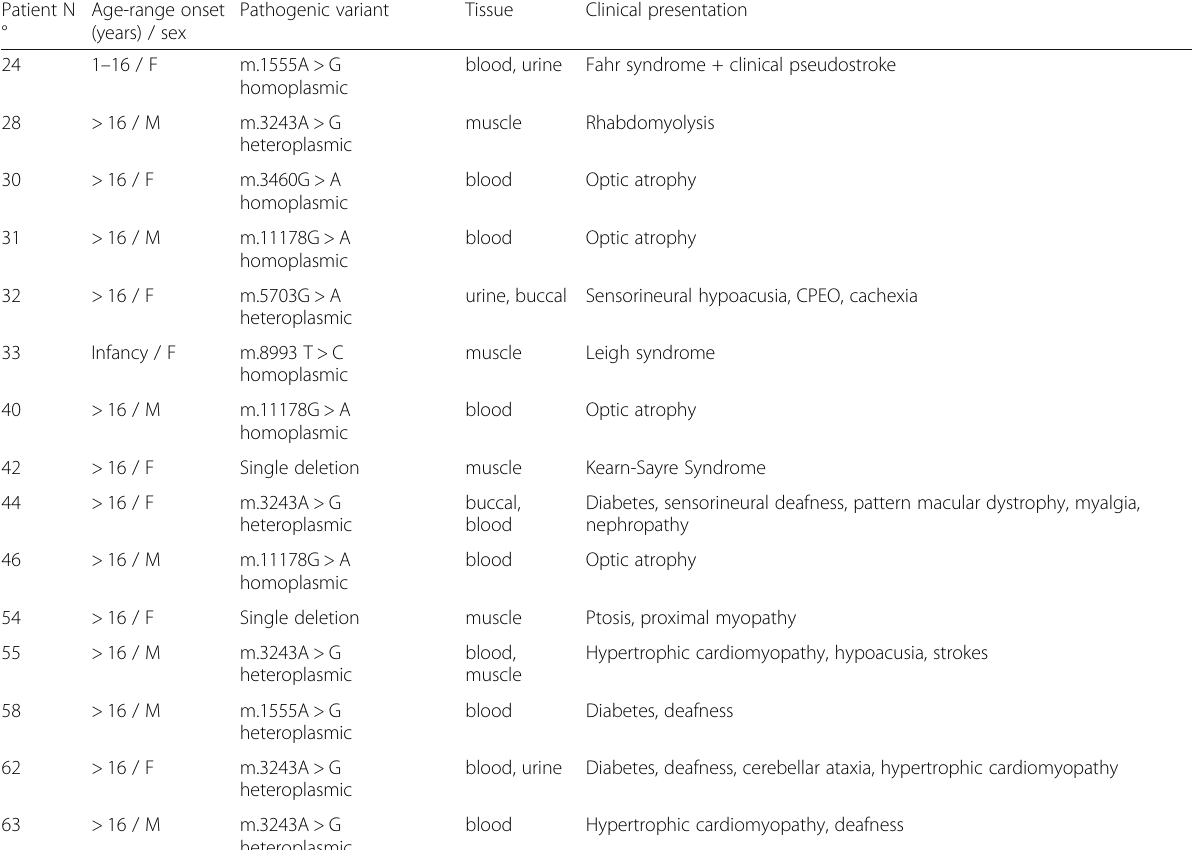
Table 2 Pathogenic variants identified by the NGS analysis in this study. Variants identified in mtDNA Patient N